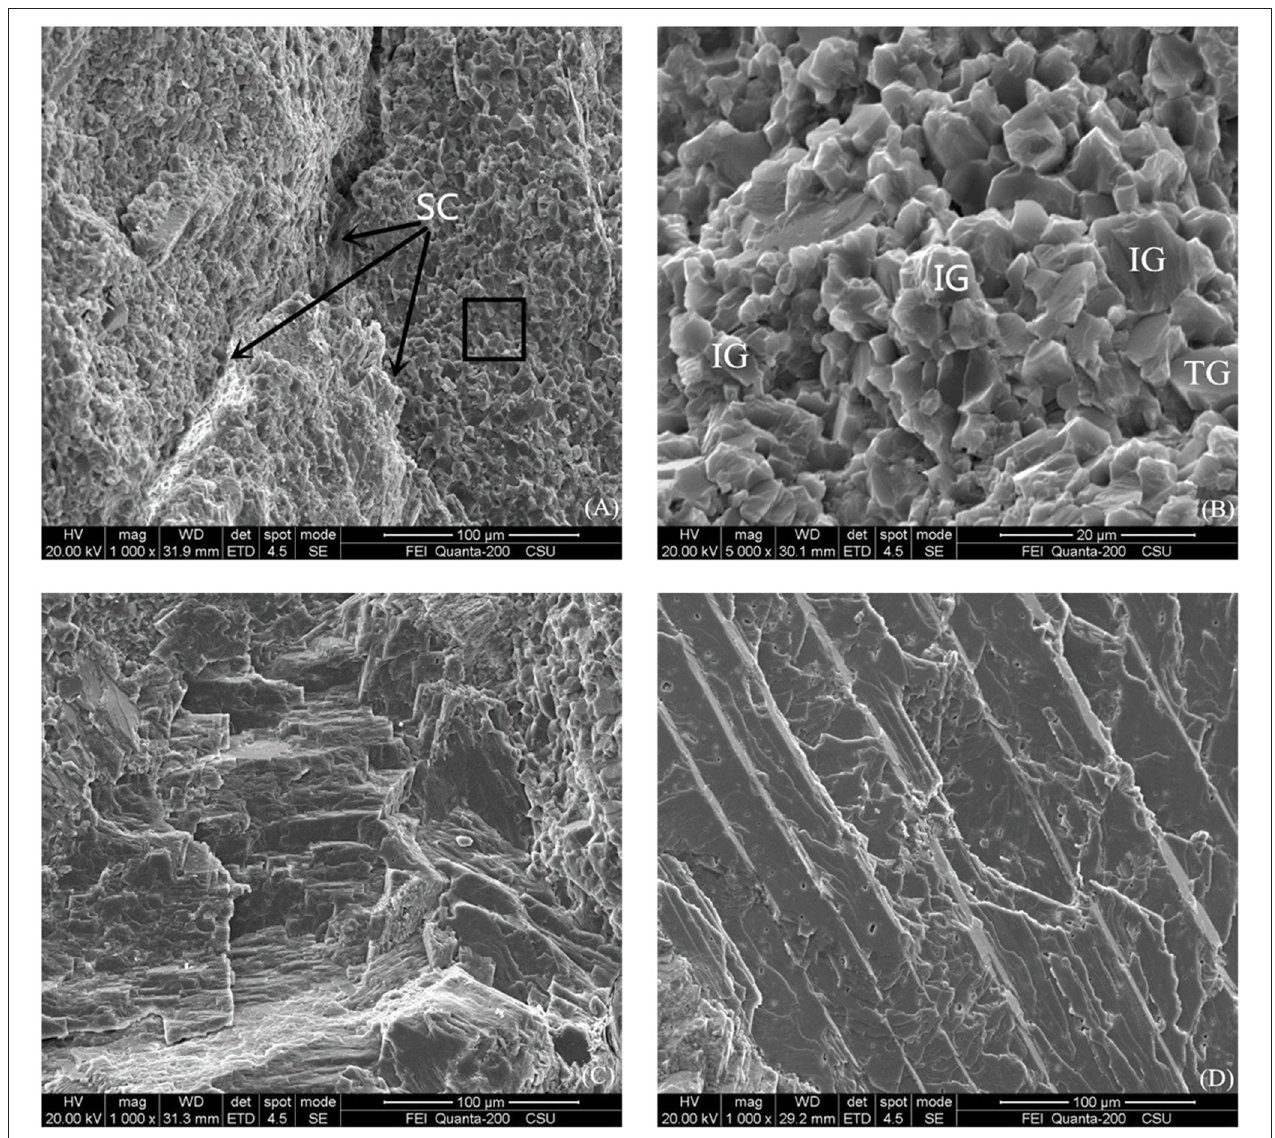
FIGURE 8 | SEM photos of the fracture surfaces for limestone under Brazilian split test. (A) Secondary Cracks (SC) on the fracture surface; (B) inter-granular and trans-granular cracks; (C) coarse sidesteps on fracture surface; (D) smooth steps with streamline patterns on the fracture